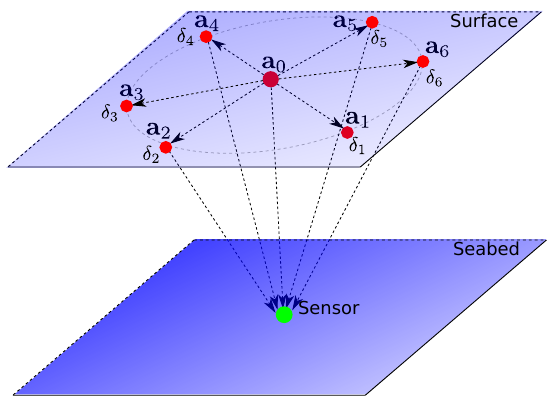
Figure 2. An illustration of the Underwater Positioning Scheme (UPS). Multiple anchors lie on the sea surface and a sensor at seabed. UPS process starts with a broadcast of a beacon signal from the lead anchor with location a 0 , which is then followed by broadcasts from the assistant anchors with locations a i , ∀ i = 1, · · · ,6. A beacon signal contains the tuple ( a i , δ i ) , where δ i is the delay between the instant when an assistant anchor receives the beacon signal from the lead anchor and the instance when it broadcasts its own signal. The sensor silently listens to all the signals, records their arrival times and then estimates its